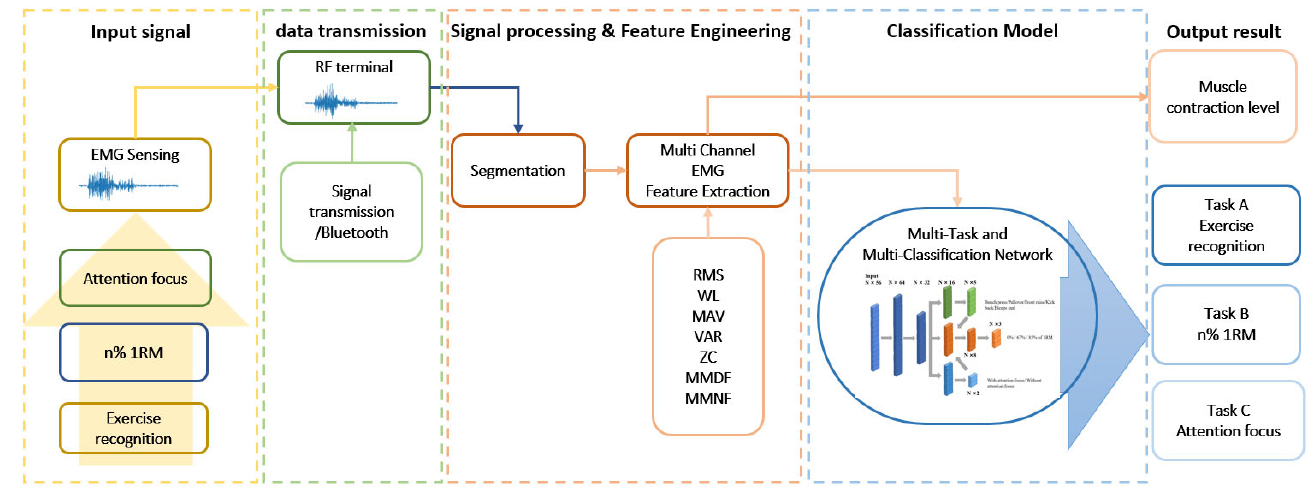
Figure 2. System framework.